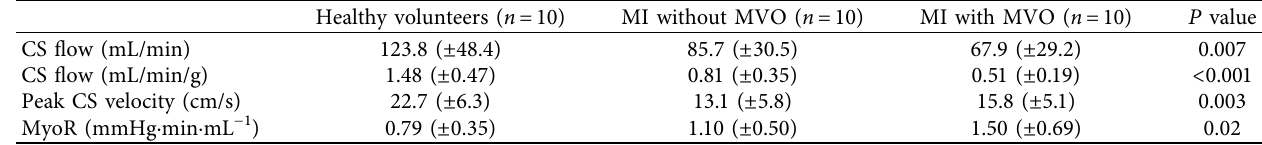
Table 3: Coronary sinus fow results stratifed by clinical group.